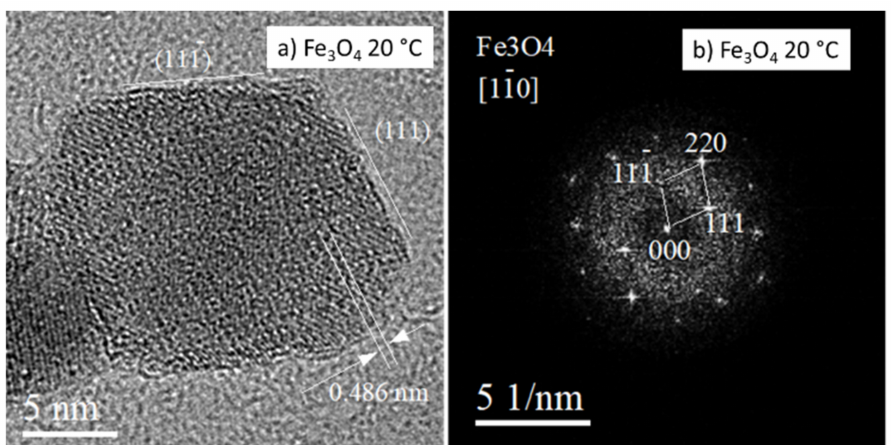
Figure 2. HRTEM detail of naked NP produced at 20 ◦ C ( a ). Relevant FFT pattern confirming octahedral morphology of NP faceted predominantly by {111}-type planes ( b ).